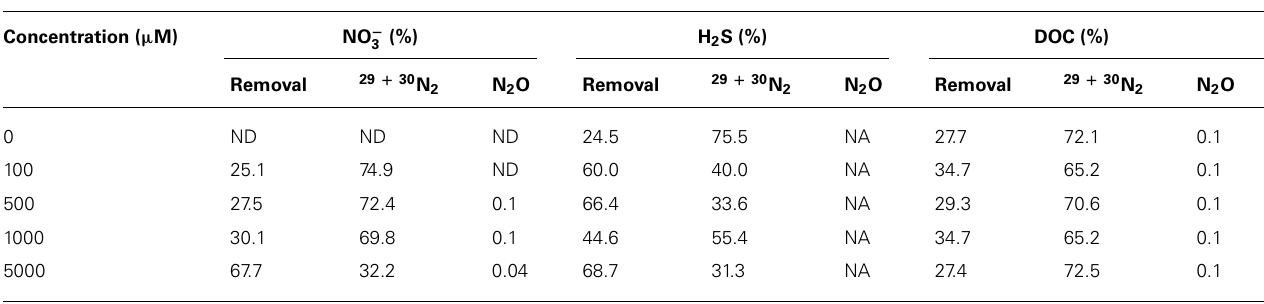
Table 1 | Percent of end products observed in samples amended with nitrate, sulfide, and DOC for all concentration